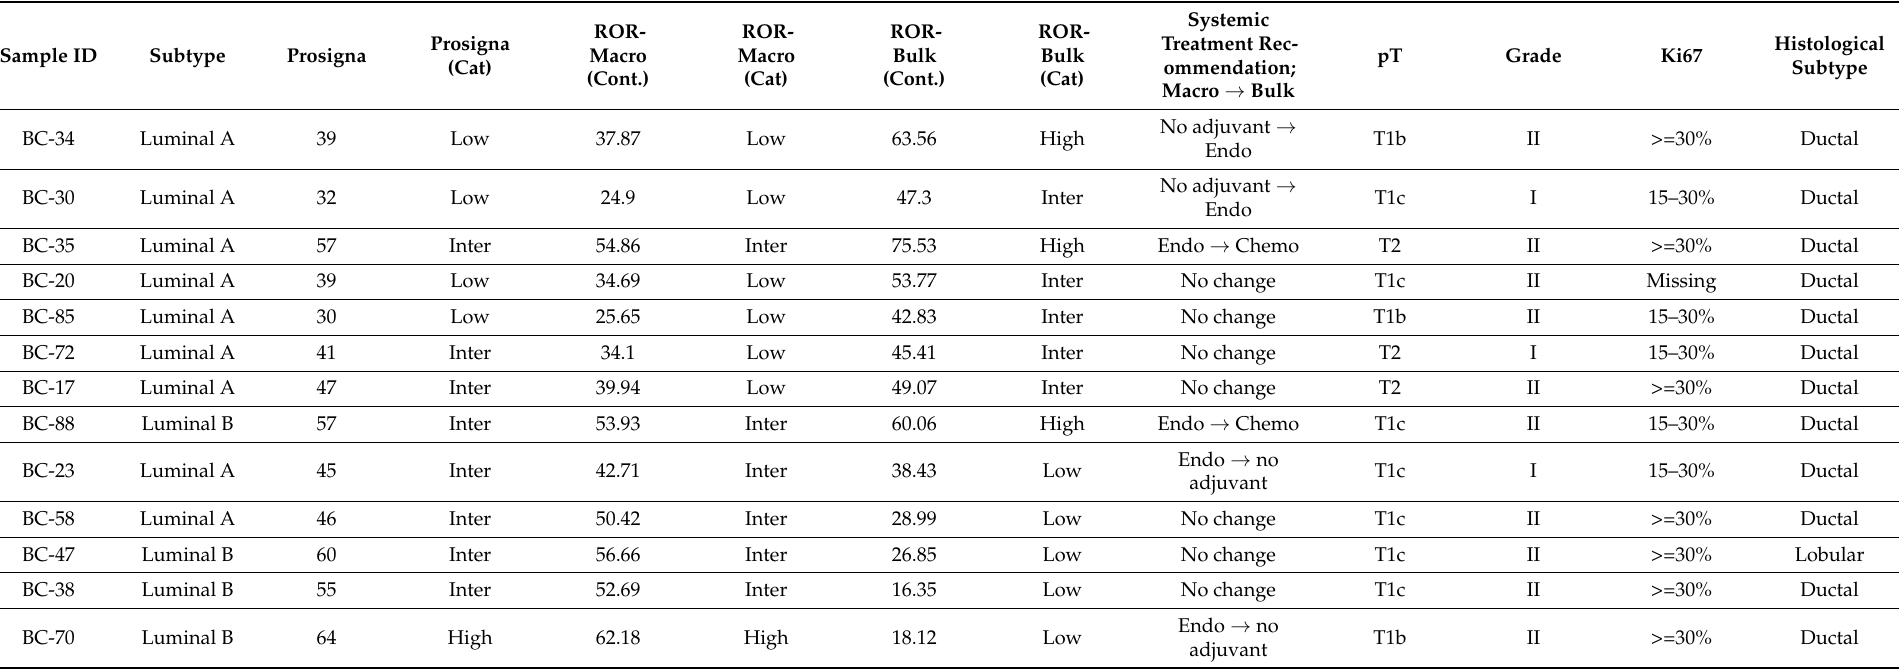
Table 2. ROR scores and corresponding categories for the 13 discordant cases between ROR-Macro and ROR-Bulk, ordered in rows according to the difference in risk score. Potential change of treatment recommendations within this ER+ HER2+ subpopulation is indicated in the systemic treatment recommendation column. Treatment is based on the Norwegian guidelines, including the use of the Prosigna test